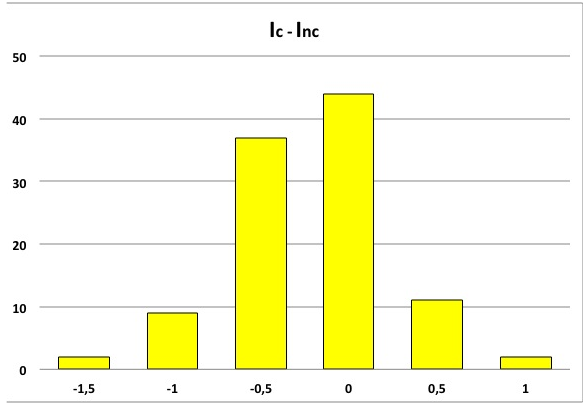
Figure 9. Residuals coeval intensity vs non coeval intensity, related to the 105 localities for with both coeval and non coeval sources are available.